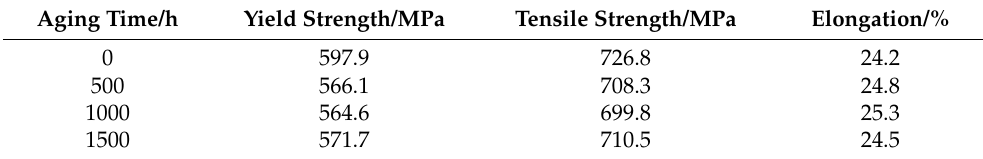
Table 5. Mechanical properties of aged 0.004ZrD steel.